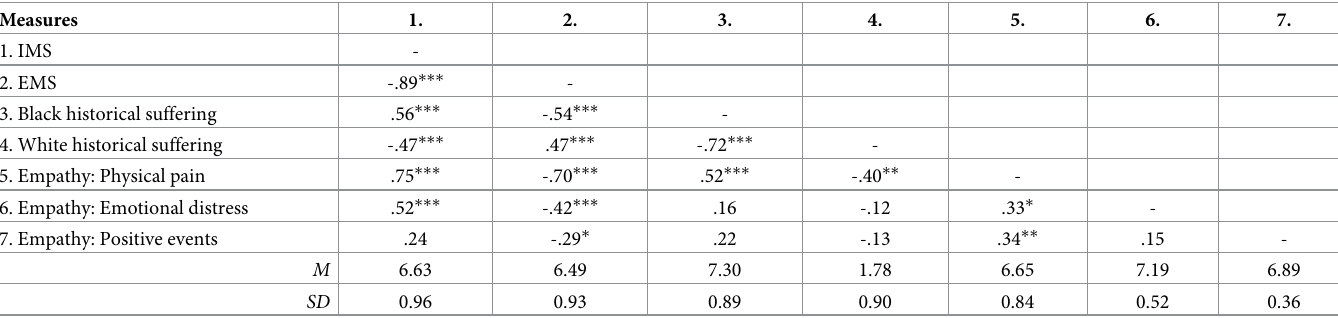
Table 2. Individual difference measures: Descriptive statistics and variable intercorrelations.